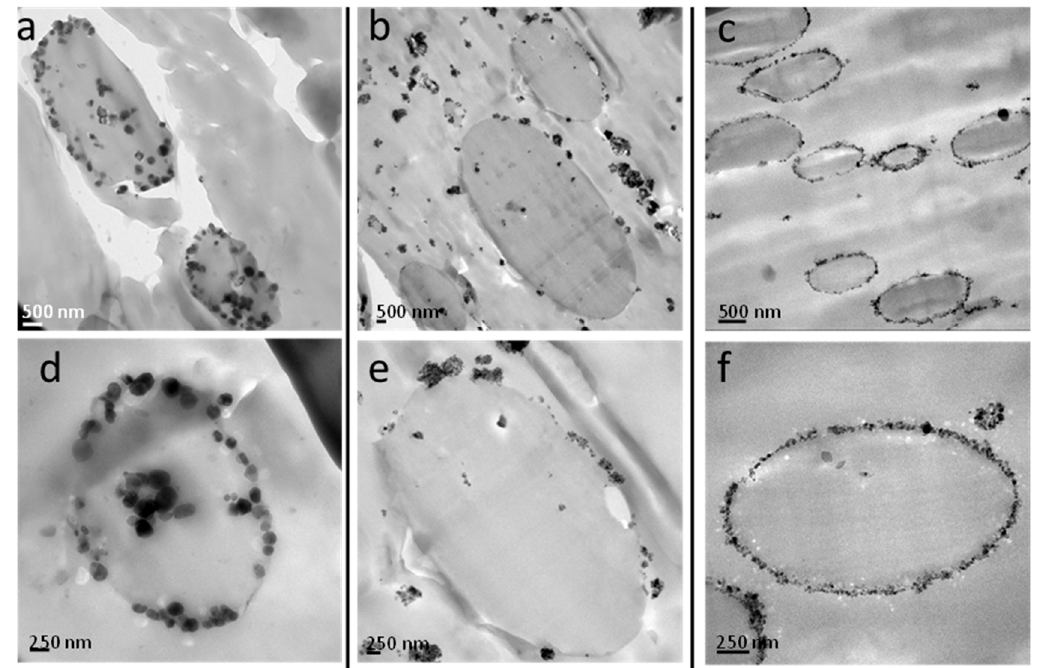
Figure 8. TEM images of PBNANO-12% containing: ( a , d ) hydrophilic (hphi), ( b , e ) hydrophobic (hpho), and ( c , f ) hydrophobically modified (hphoM) TiO 2 .